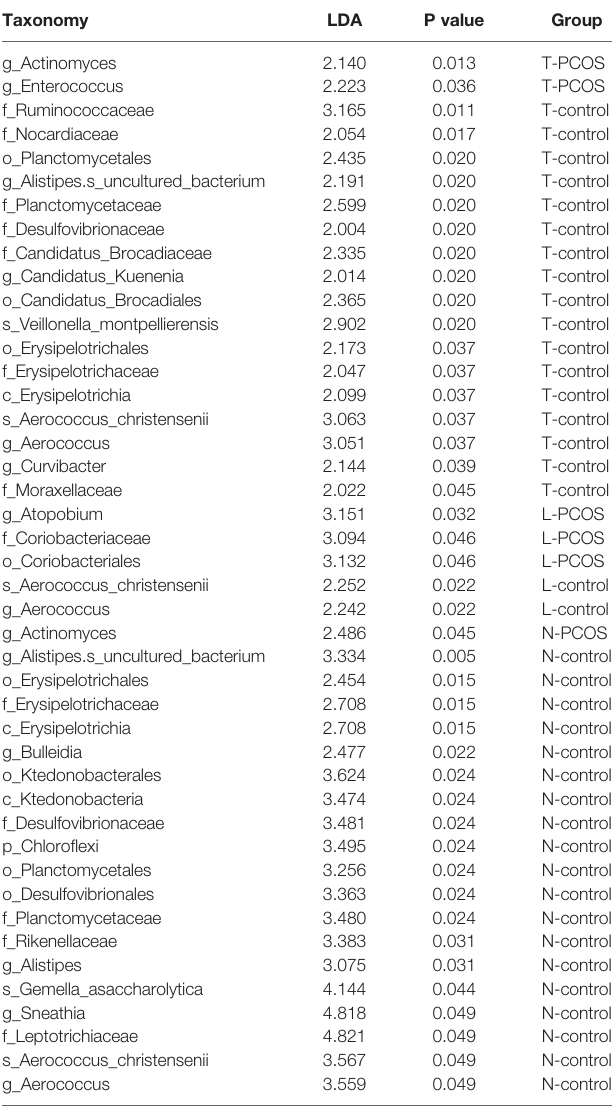
TABLE 2 | Linear discriminant analysis (LDA) scores and P values between_ the total polycystic ovary syndrome (PCOS) and total control groups, the L-PCOS and L-control groups, and the N-PCOS and N-control groups.